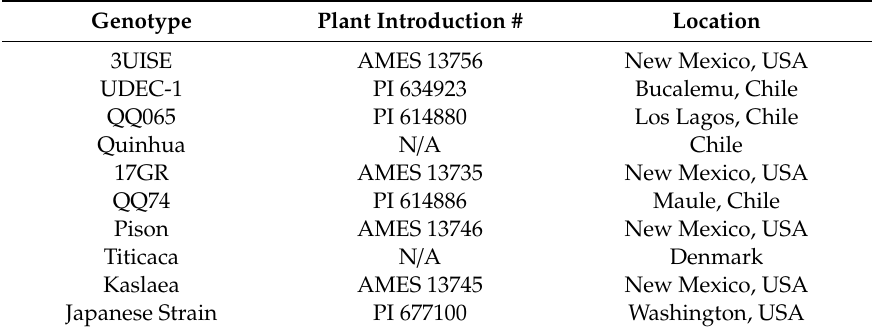
Table 1. List of the ten quinoa genotypes used in this study with available information on plant introduction number (#) and geographical origin